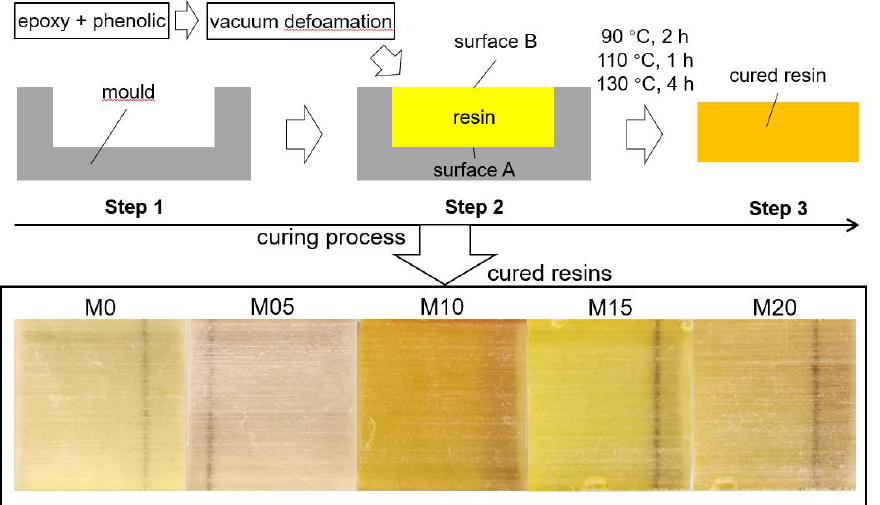
Figure 1. Curing process and cured resins.